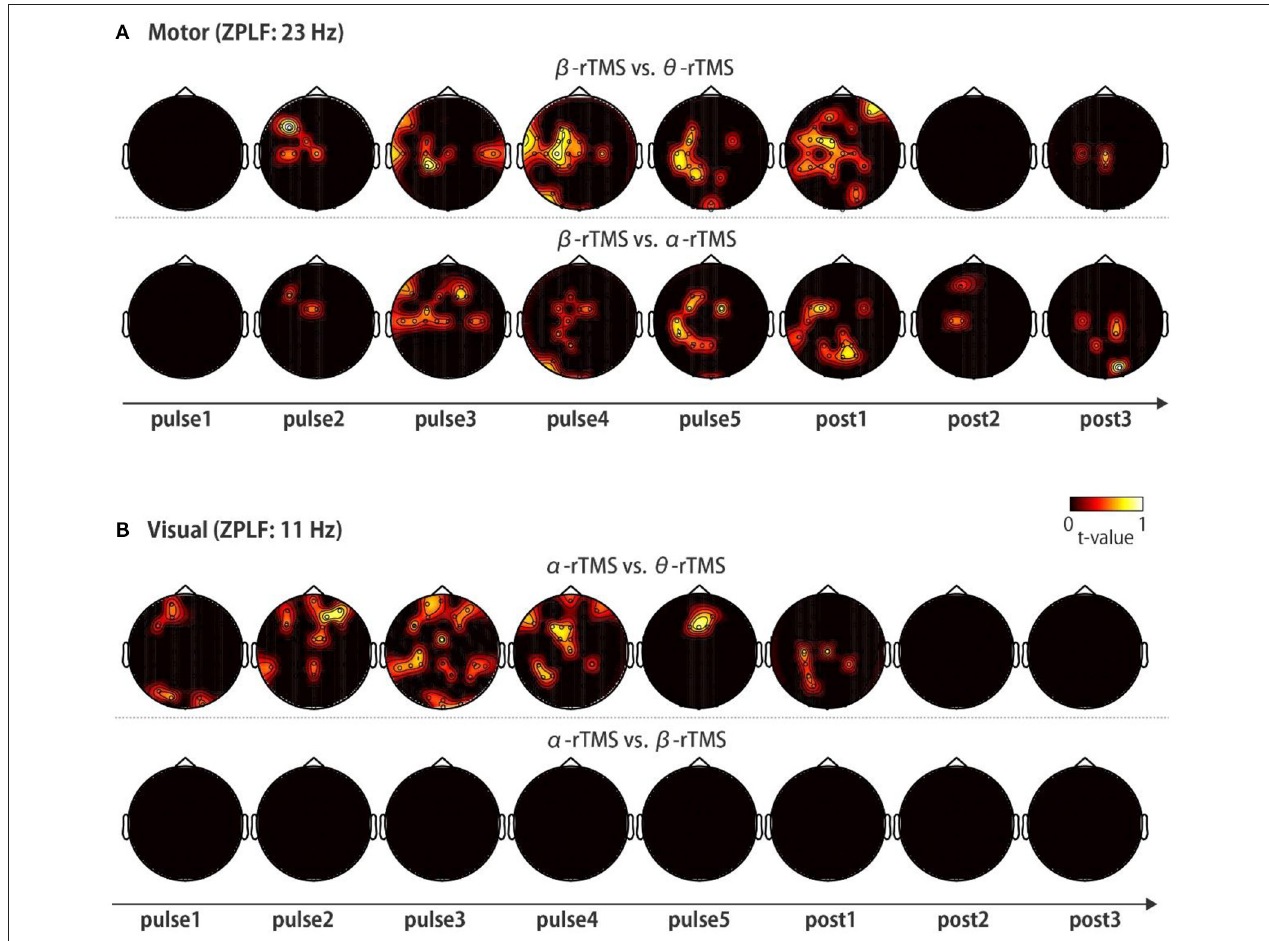
FIGURE 6 | Topographic representation of the ZPLF. Each map with t -values was obtained from comparisons of the ZPLF between β -rTMS and the other stimulation frequency, i.e., θ -rTMS (upper panels) and α -rTMS (lower panels) for motor cortex stimulation (A) , and between α -rTMS and the other frequency, i.e., θ -rTMS (upper panels) and β -rTMS (lower panels) for visual cortex stimulation (B) ( p <